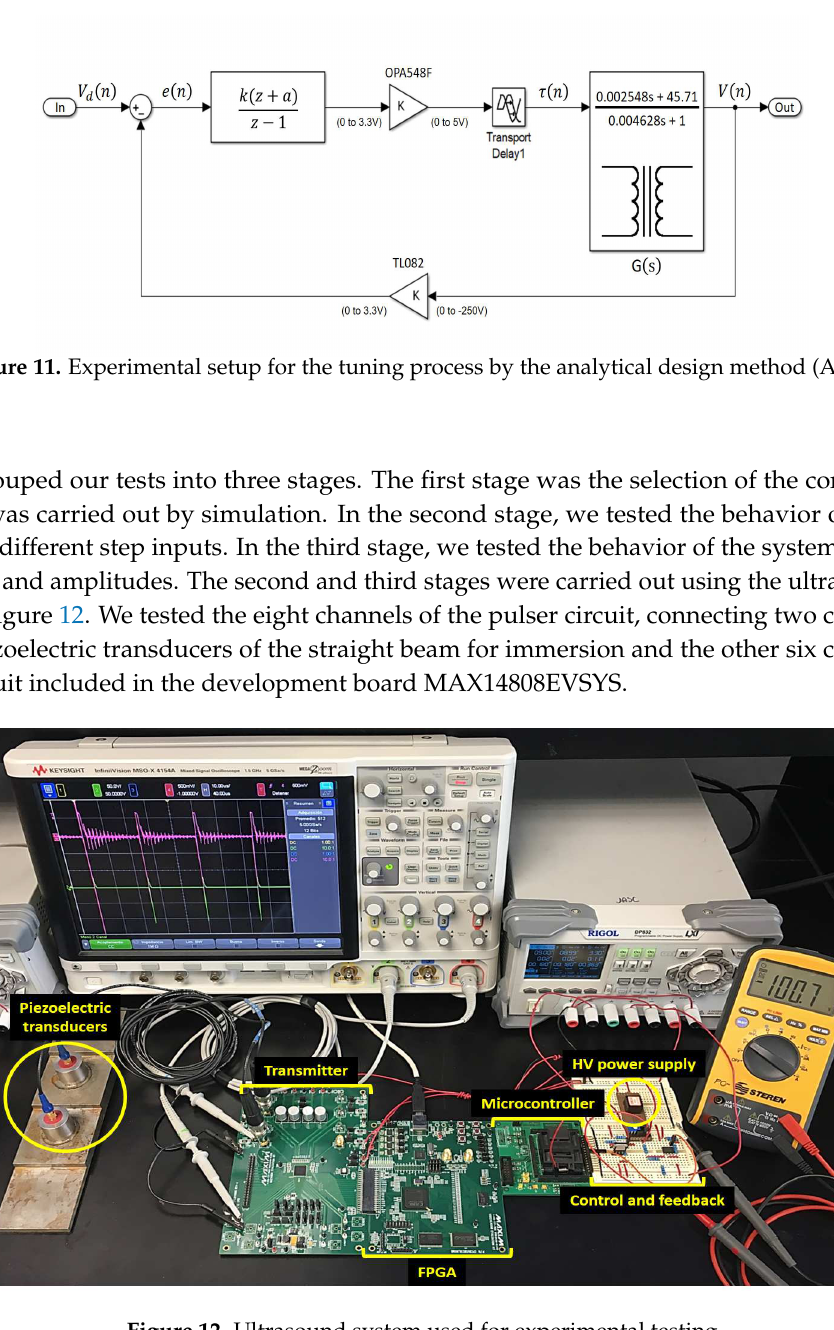
Figure 12. Ultrasound system used for experimental